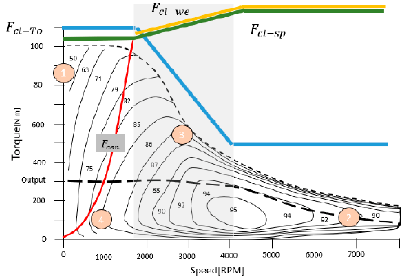
Figure 7. ( a ) Possible operational situations: low speed, high torque ( b ); high speed, high torque ( c ); low speed, low torque ( d ); high speed, low torque ( e ).